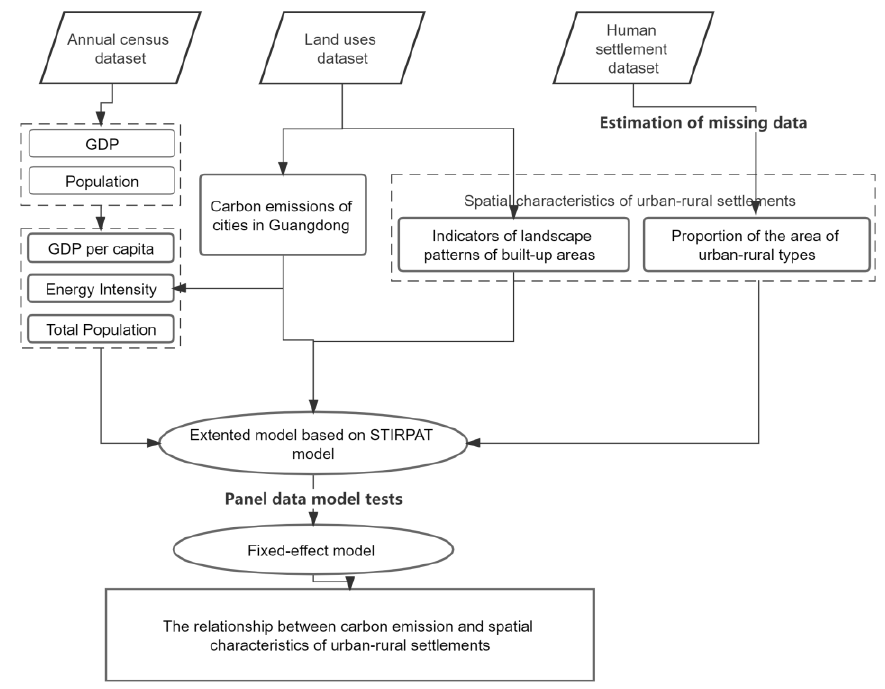
Figure 2. Research